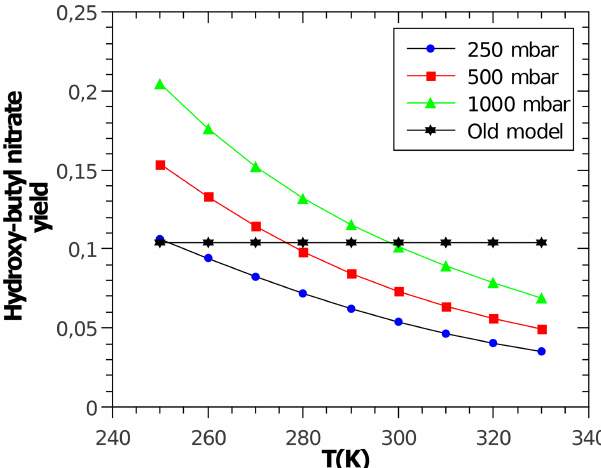
Figure 2. Temperature- and pressure-dependent nitrate yield for the secondary hydroxybutyl peroxy radical obtained and calculated by MOM. A constant yield of about 10% (“Old model”) is used by